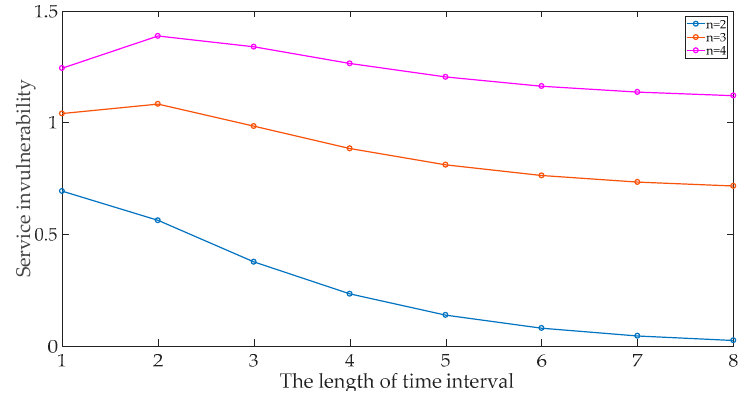
Figure 12. Performance analysis of the SWIM service dynamic migration method.